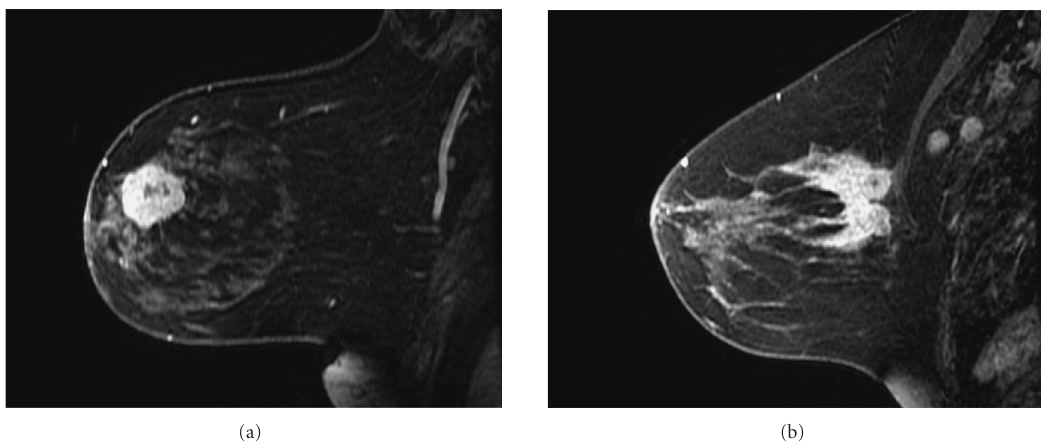
Figure 3: While the “onion-peeling” method has been demonstrated to be useful in animal xenografts, the specific assumption of radial heterogeneity may not apply to all in vivo human tumors. It can only be used on lesions with regular shape and a radial enhancement pattern (a). The lesion in (b) has an irregular, speculated shape that makes it di ffi cult to define its center. Its enhancement pattern is also more stochastic, without a clear di ff erence between the periphery and the tumor core. Applying the “onion-peeling” method to a tumor like this will not generate much useful information about the underlying tumor